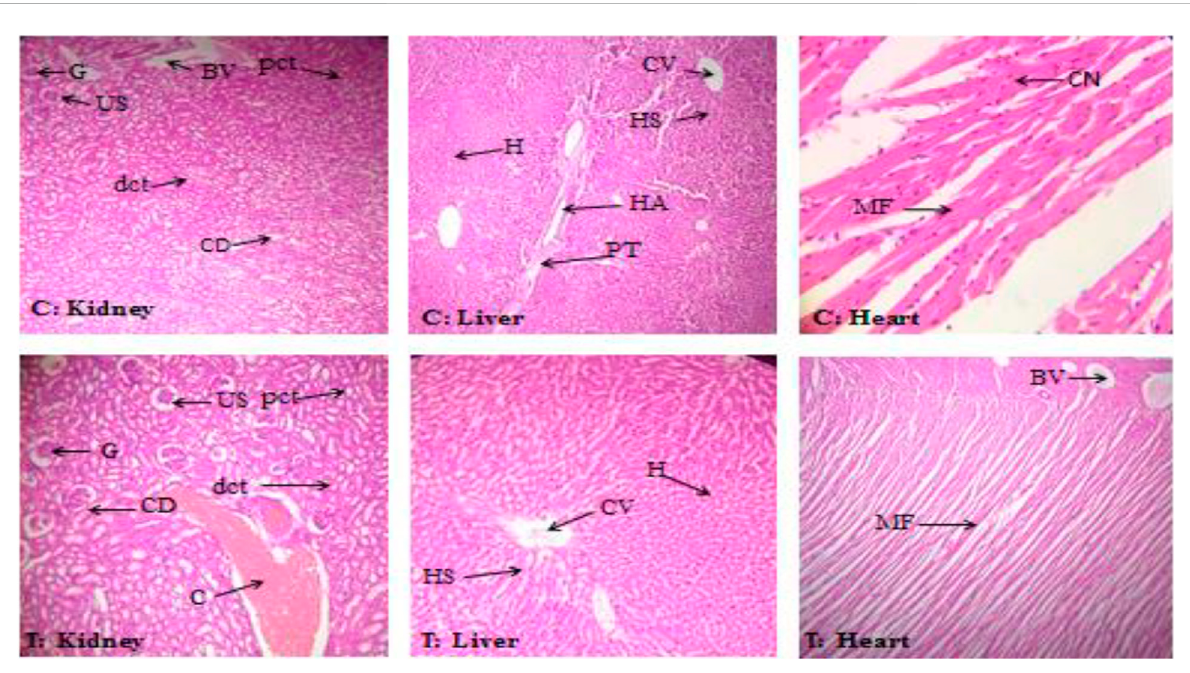
FIGURE 1 Histopathological assessment of kidney, liver, and heart of the control group (C) and the treatment group (T) at 40 × and 10 × magni fi cation. G: glomerulus; US: urinary space; BV: blood vessel; pct: proximal convoluted tubules; dct: distal convoluted tubules; CD: collecting duct; C: congestion; H: hepatocytes; CV: central vein; HS: hepatic sinusoid; HA: hepatic artery; PT: portal triad; CN: central nuclei; MF: myocardial fi brils.